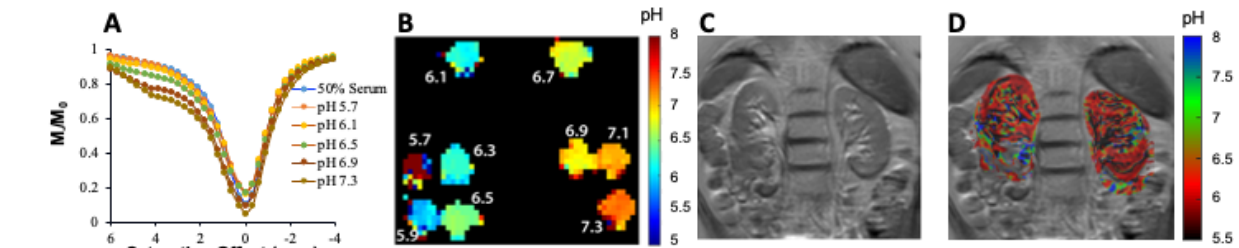
Figure 8. Example of ratiometric measurement of pH using 25 mM iopamidol in blood serum at 3 T using B 1 = 2 µ T, ( A ) CEST z-spectra at pH = 5.7, 6.1, 6.5, 6.9 and 7.3 acquired for 63 offsets between − 4 and 6 ppm; ( B ) pH maps of phantom; ( C ) T2 image of the abdomen in first healthy subject; ( D ) pH map of the kidneys after injection of iopamidol. CEST data were acquired for 18.9 min using t sat = 2 s, ω 1 = 1.5 µ T and TR = 6 s, at repeated offsets = 20,000, 6.1, 5.6, 5.1, 4.6 and 4.1 ppm, respectively. CEST contrast at 4.6 and 5.6 ppm was used for pH calculation. This set of offsets was necessary to partially compensate for the B0 homogeneity shown in the B0 maps across the kidneys on this